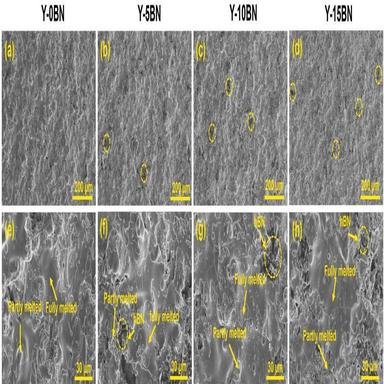
Surface morphologies (a–d) and magnification (e–h) of the Y–0BN, Y–5BN, Y–10BN, and Y–15BN coatings, respectively.